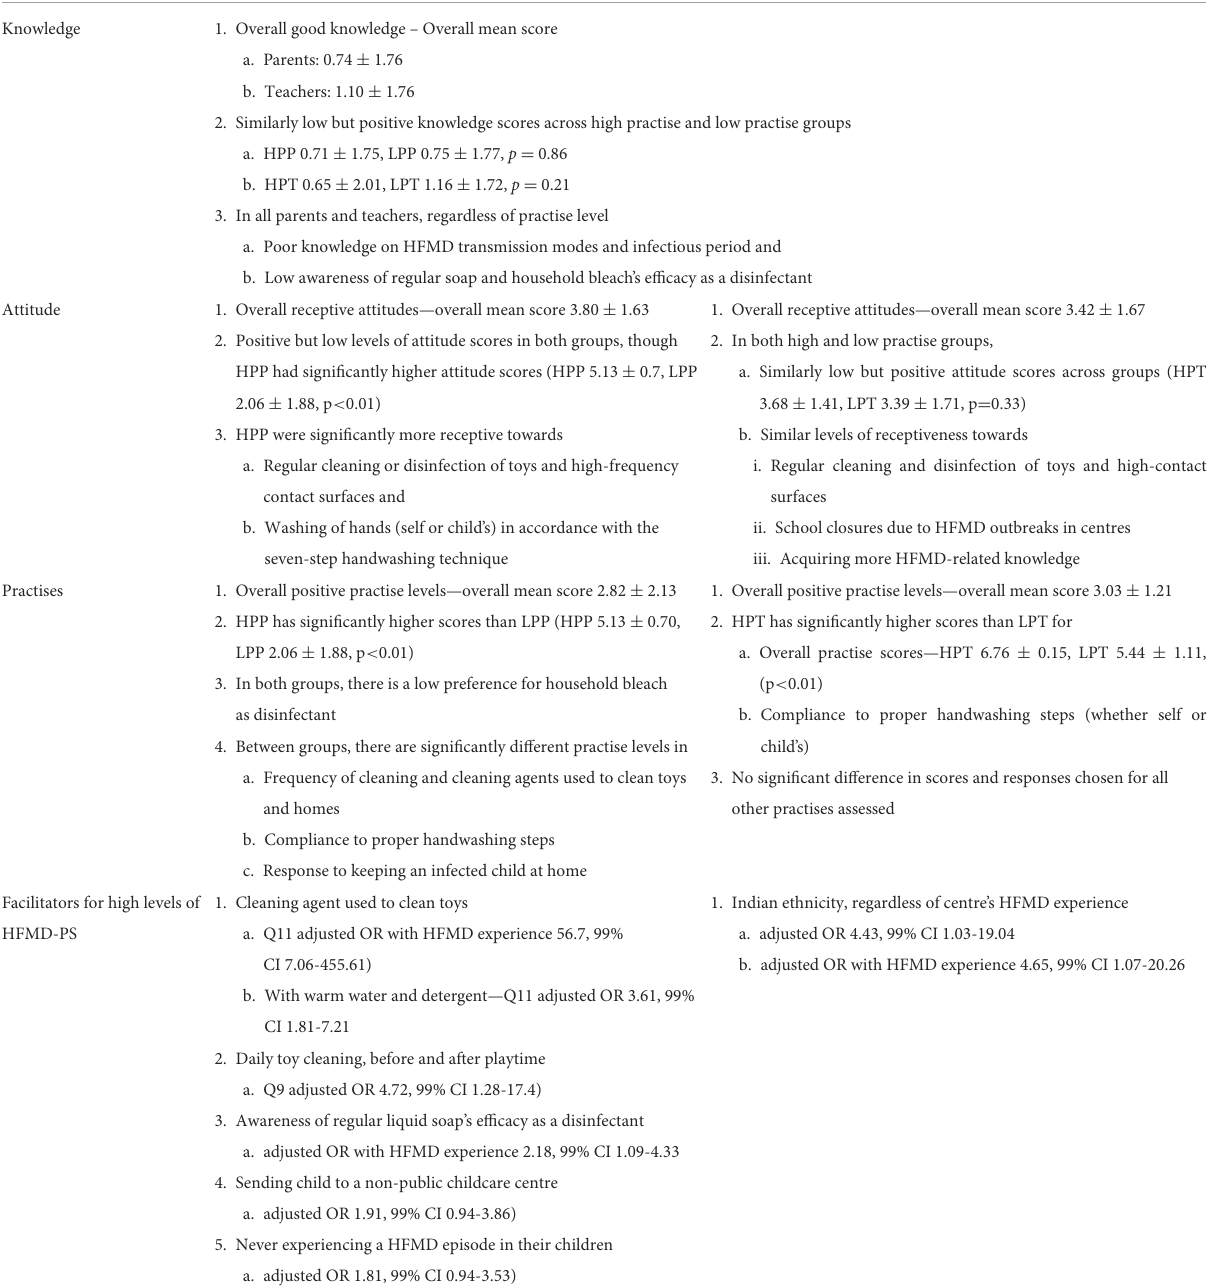
TABLE 3 Key study findings on HFMD-PS KAP and facilitators.